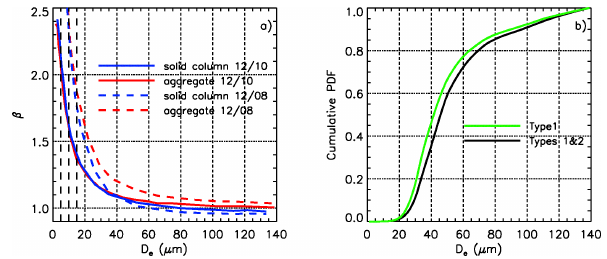
Figure 7. (a) Theoretical microphysical indices β 12 / 10 (solid lines) and β 12 / 08 (dashed lines) against effective diameter D e for a cloud composed of hexagonal solid columns (blue) and of aggregates (red), with τ a = 0.25. The vertical dashed lines highlight the large sensitivity to D e smaller than 15µm (see text). (b) Cumulative probability density function of D e retrieved from IIR microphys- ical indices for type 1 clouds (green, measured R BG ) and by com- bining type 1 and type 2 clouds (black). Data set: single-layered cirrus randomly oriented ice with high confidence, base temper- ature < − 20 ◦ C, extended CALIOP optical depth measurements, 2 τ a >0.3, over ocean, 2008.